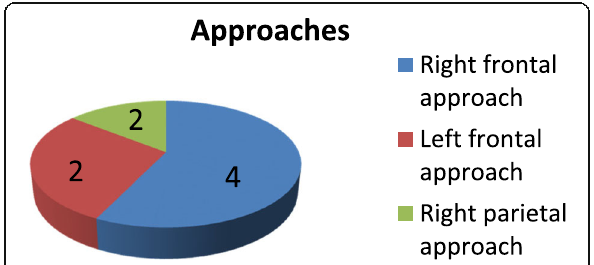
Fig. 3 A graph outlining the frequencies of different approaches